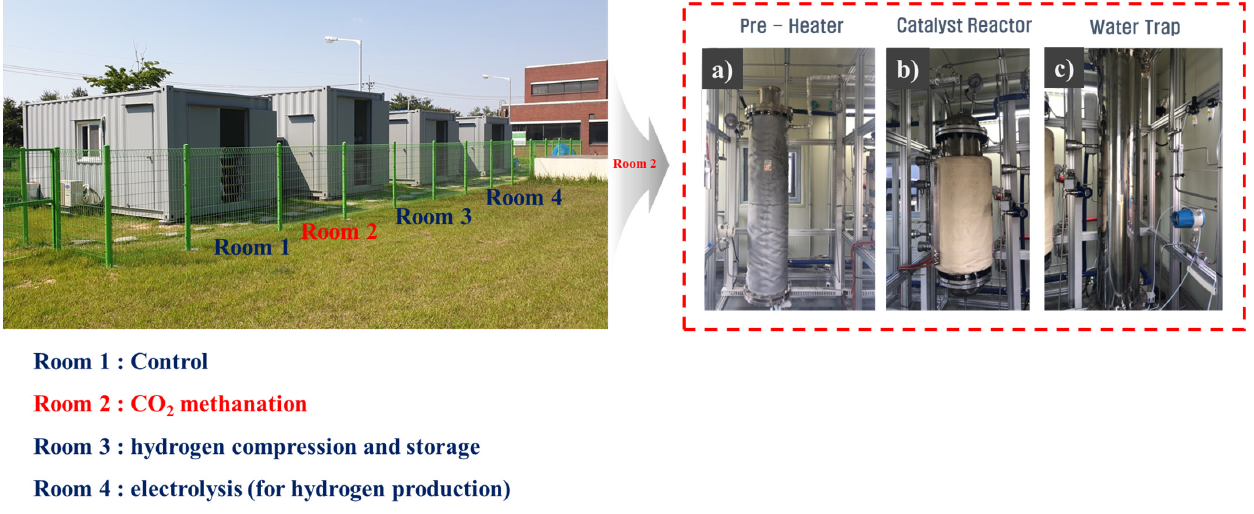
Figure 8. CO 2 methanation processes installed in sewage disposal plants in Korea: ( a ) pre-heater, ( b ) catalyst reactor, and ( c ) water trap.